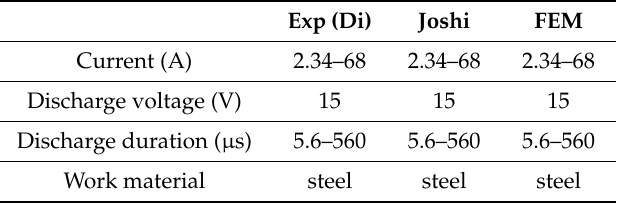
Table 1. Performance parameters of MRR simulation.